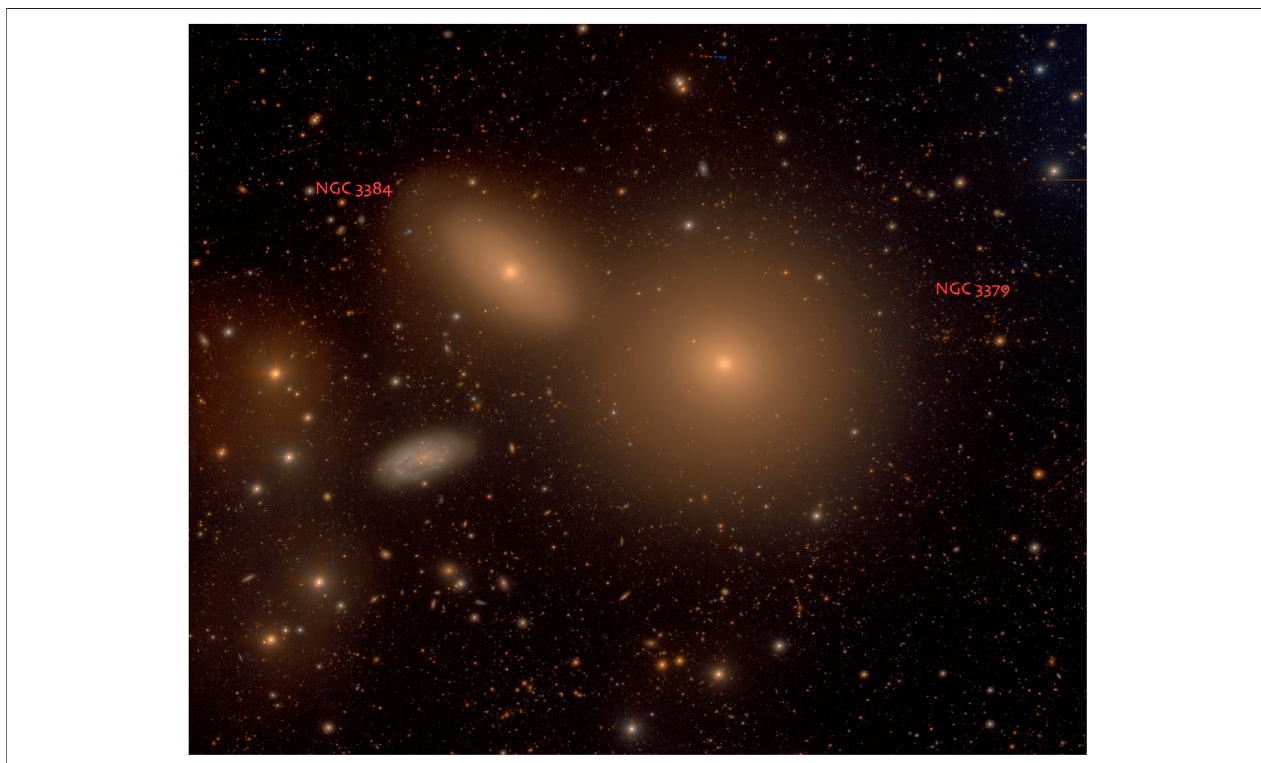
FIGURE 1 | Color composite (gri) VST image of the central regions of LEO I pair. The image size is 40,×,37 arcmin. North is up and East is to the left. The two brightest group members are labelled in red on the